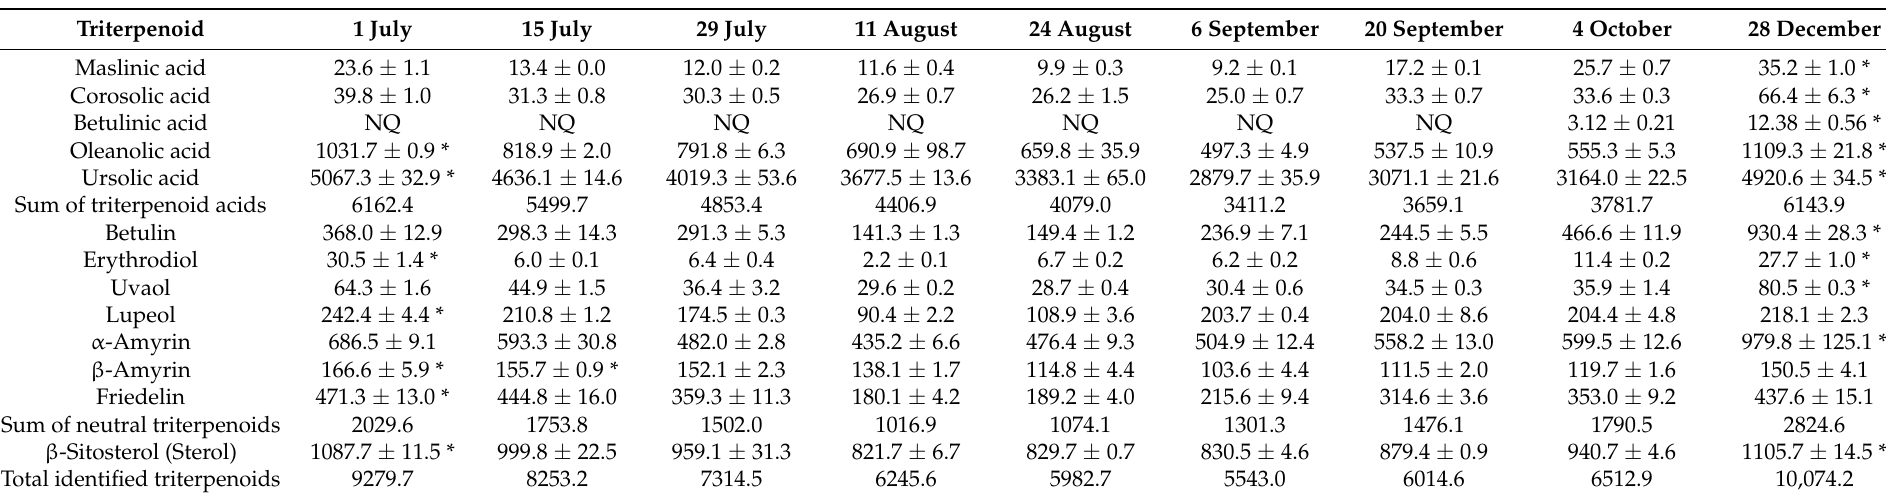
Table 3. Contents of triterpenoids ( µ g/g DW ± SD) in lingonberries during different phenological stages. Values marked with * in the same row indicate the highest ( p < 0.05) amounts in samples. ND—not detected, NQ—not